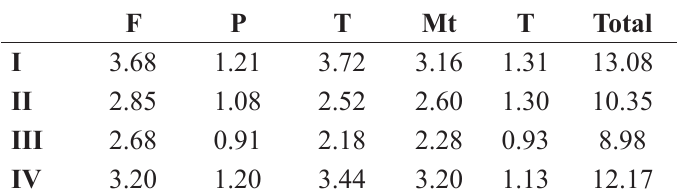
l egs ( Fig . 6B–C). Formula 1423, with leg III distinctly shortened. Leg I modified at metatarsus, with strong kink extending dorsally, creating metatarsal process at least twice as high as apical end of